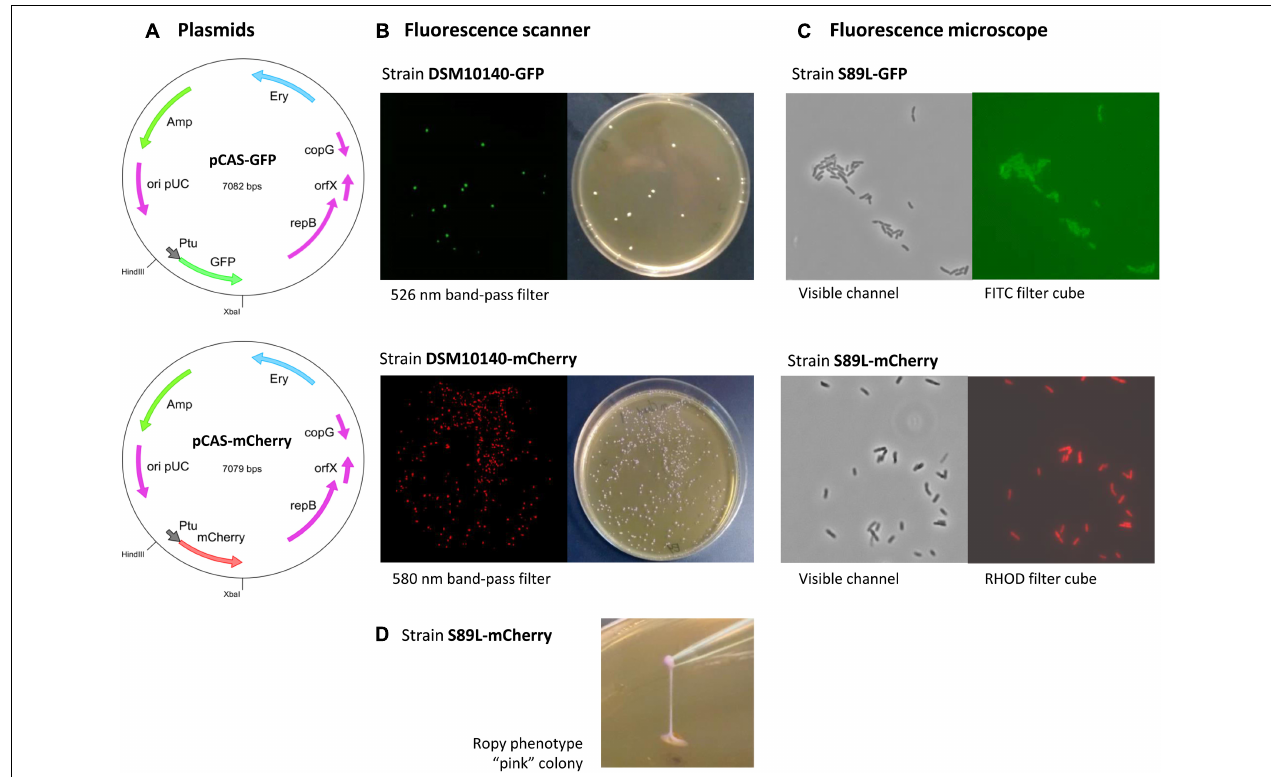
FIGURE 2 | Physical map of pCAS-GFP and pCAS-mCherry, in which the GFP and mCherry genes are located downstream from the elongation factor Tu promoter (P tuf ) from B. animalis subsp. lactis DSM10140 (A) . Detection of fluorescence green (top) or red (bottom) colonies of B. animalis subsp. lactis DSM10140-GFP and DSM10140-mCherry, respectively, using the Typhoon 9400 scanner fluorescence scanner (left hand photographs) and aspect of the colonies visualized with a conventional camera (right hand photographs) (B) . Fluorescent B. animalis subsp. lactis S89L, transformed with pCAS-GFP (top) and pCAS-mCherry (bottom), visualized with the Leica DMi8 inverted microscope using a 100 × oil immersion objective (C) . Strain B. animalis subsp. lactis S89L-mCherry showing a colored